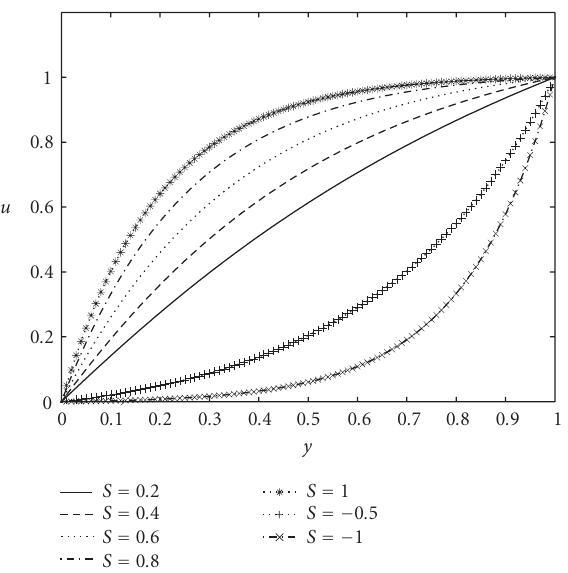
Figure 4.2. Main velocity u for ω = 6 . 0, Re = 5 . 0, Z = 0 . 0, t = 0 . 2, (cid:3) = 0 .